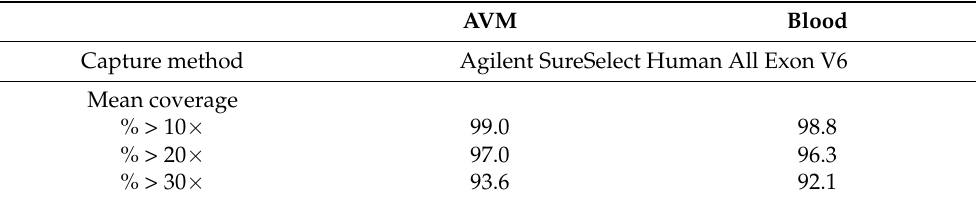
Table 1. Capture method and coverage summary of exome data.